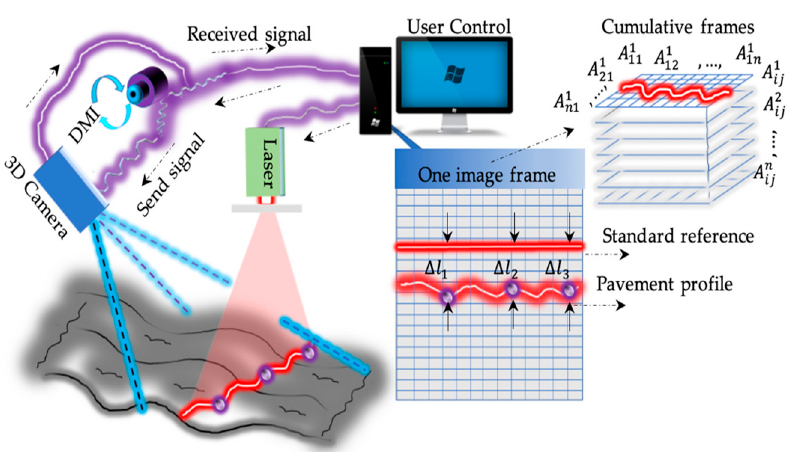
Figure 1. Schematic diagram of 3D profilometer.